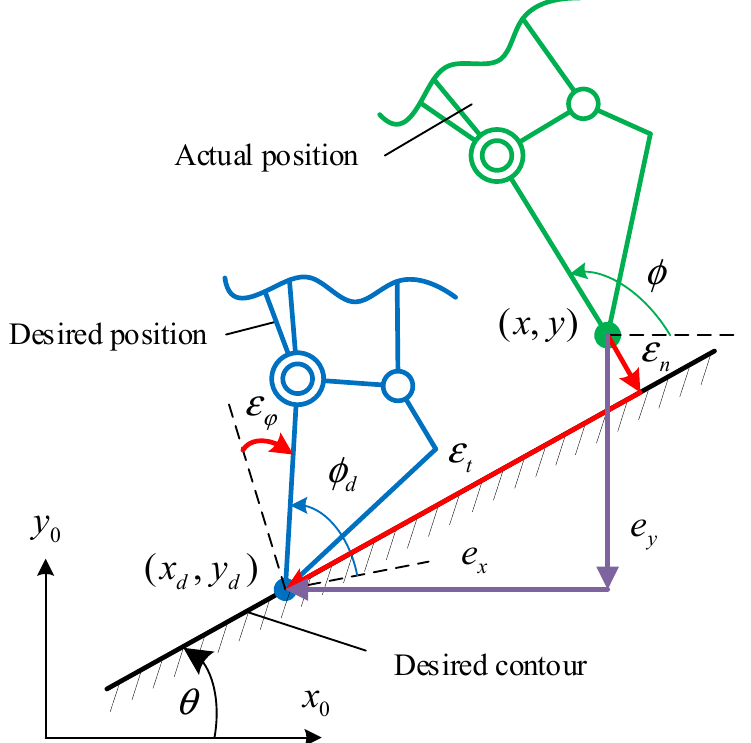
Figure 3. Illustration of the error transformation mechanism [4], Reprinted/adapted with permission from Ref. [4]. 2021, Elsevier. To maintain these prescribed performances during operation, the auxiliary control signal